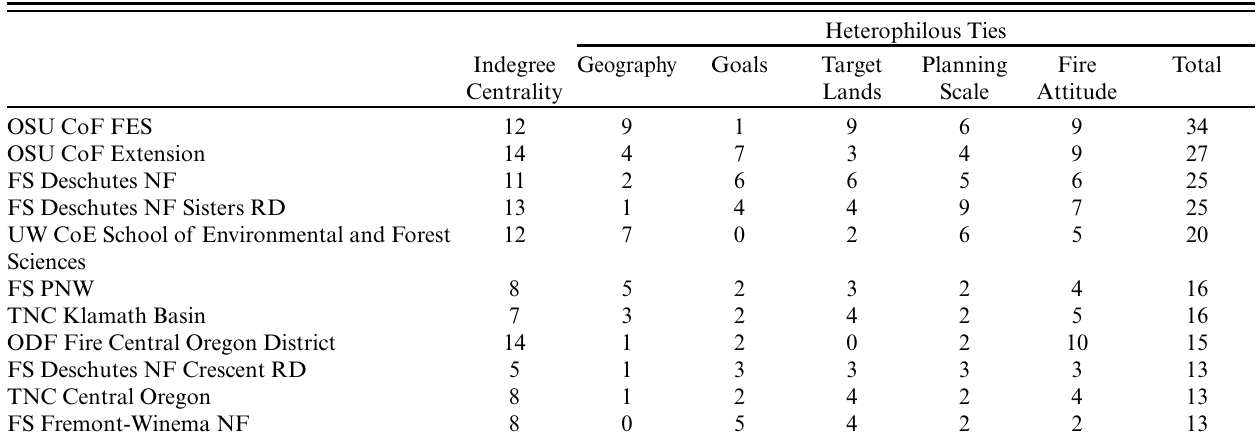
Table 4 . Top 10 organizations ranked by total number of heterophilous ties to information sources.